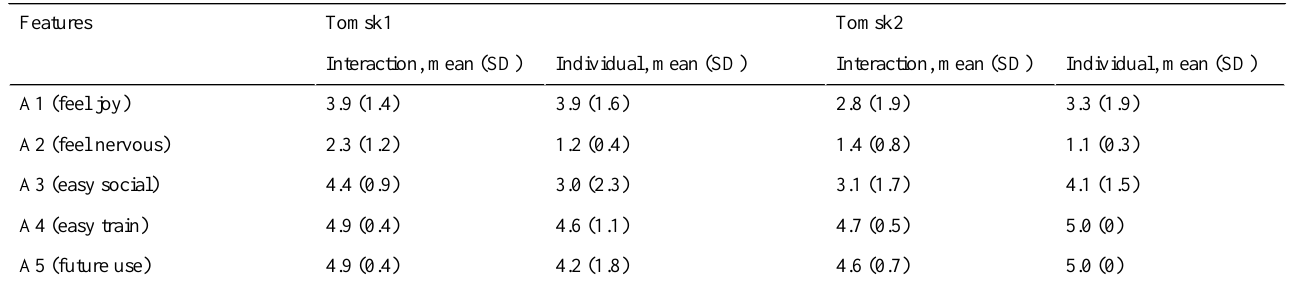
Table 4. Mean (SD) of the technology acceptance (A) responses for each group and study (range:1-5). Tomsk2Tomsk1Features